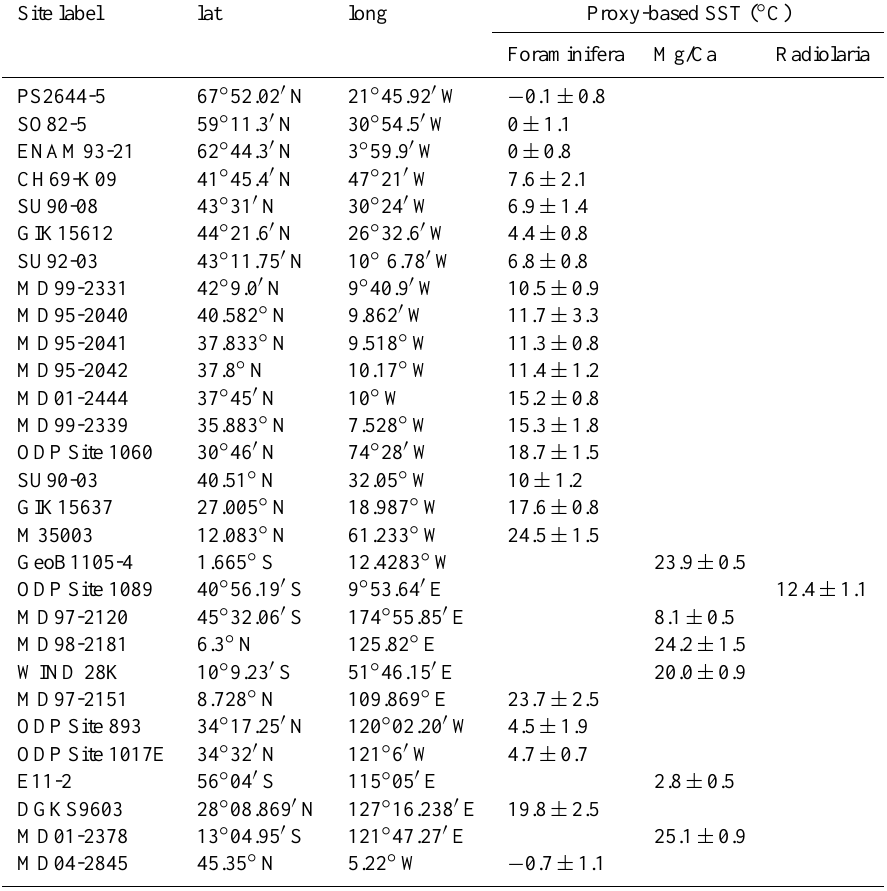
Table A6. Proxy based SST data for Northern Hemisphere winter (January–March) mean conditions with ± 1 σ error (given either by the author(s) of the respective data or estimated by the authors of this